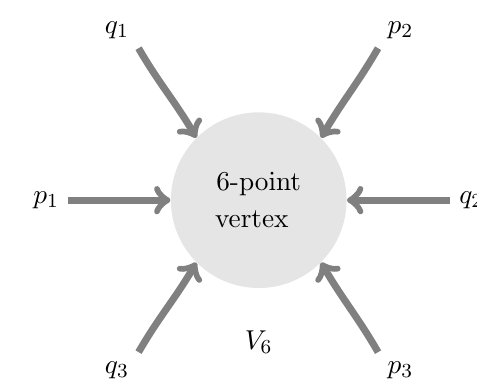
Figure 6b. V 6 vertex represents a sum over all 1PI Feynman diagrams with six external legs. The momenta are taken to (cid:13)ow